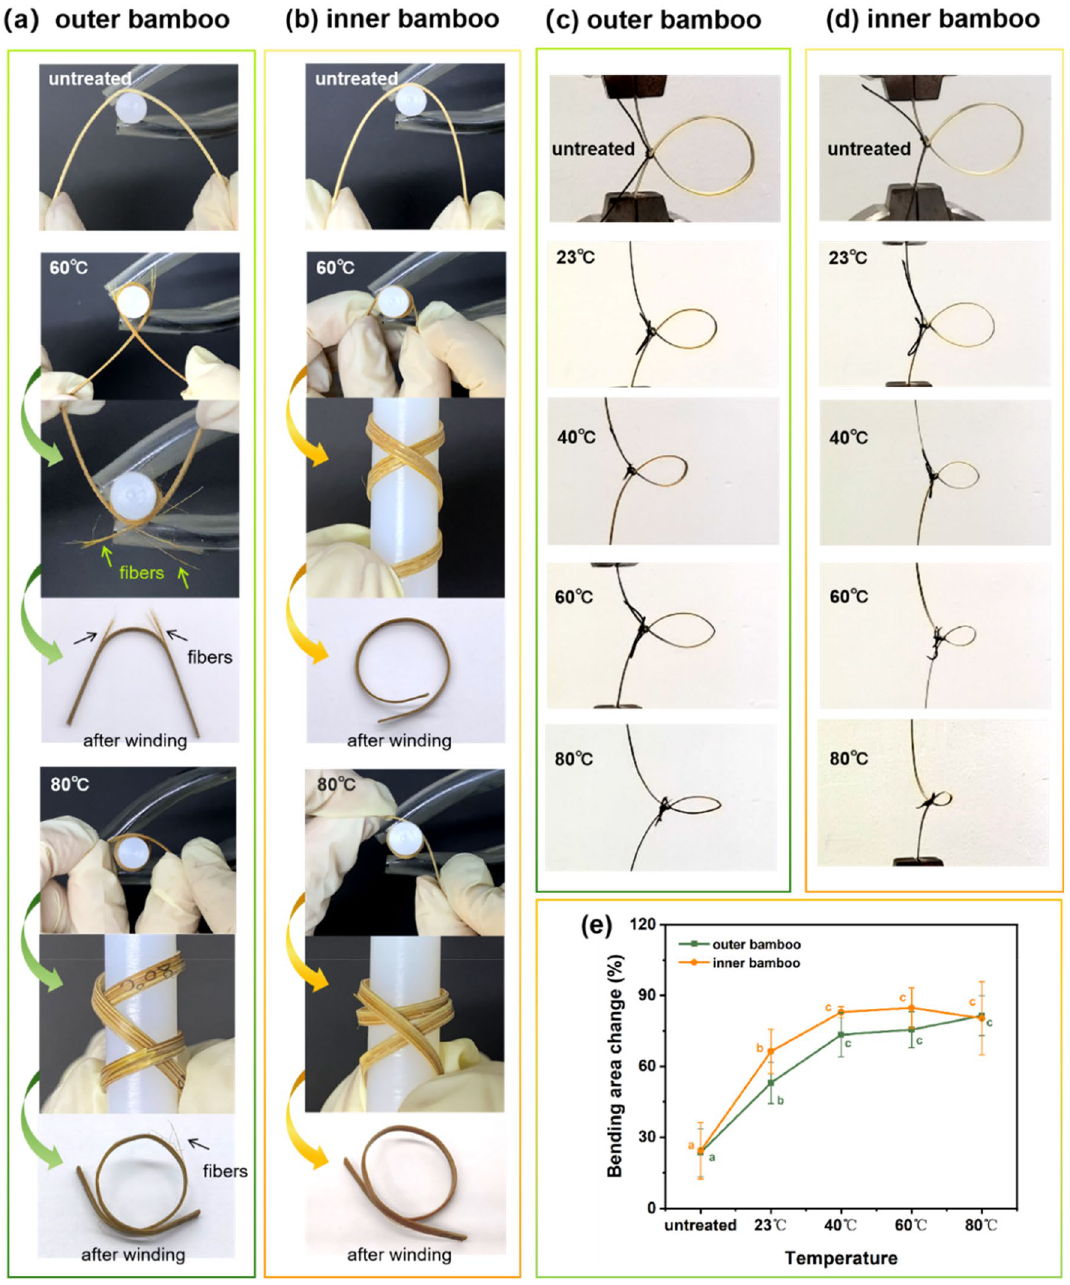
Fig. 7 Bending properties of bamboo slivers with different treated temperatures. a Maximum degree of outer bamboo slivers wound on nylon rod; b maximum winding degree of inner bamboo wound on the nylon rod; c bending area of outer bamboo slivers at fracture; d bending area of inner bamboo slivers at fracture; e bending area change of bamboo